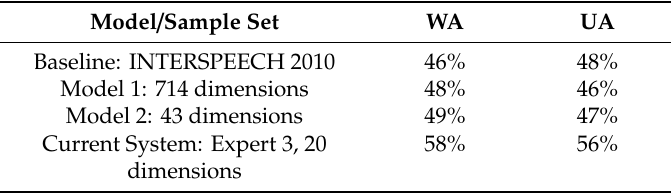
Table 4. Test result of expert 3’s high-level statistics functionals (HSF)